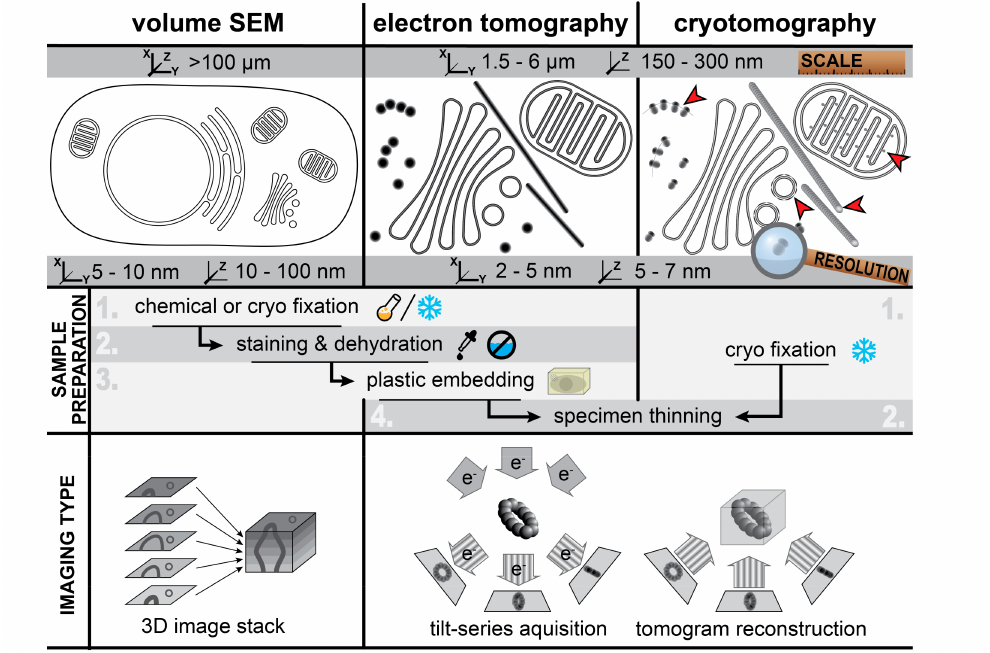
Figure 1. Characteristics of different three-dimensional (3D)-electron microscopy (EM) techniques Figure 3. D imaging of cells at different scales and resolutions: ( left ) volume scanning electron microscopy (SEM) for the imaging of large samples like whole cells and tissue, ( middle ) electron tomography (ET) of resin-embedded samples to analyze subcellular ultrastructure of specific areas in the cell, and ( right ) cryotomography to image the biological content in a near-native state. Volume SEM and ET images of resin-embedded samples have high contrast due to the heavy-metal stain used in sample preparation that accumulates on membranes and large macromolecular